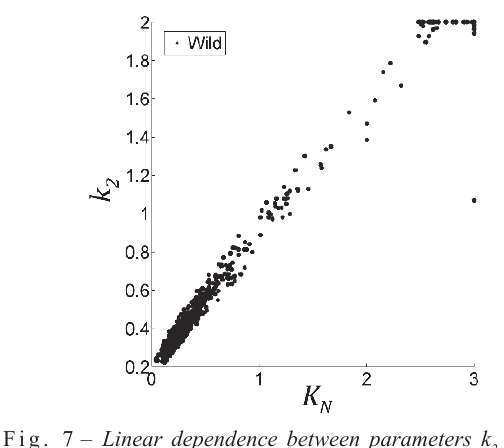
Fig. 7 – Linear dependence between parameters k direct relation exists between parameters k Fig. 7 Linear dependence between parameters k 2 – K N . A direct relation exists between parameters k 2 and K N .